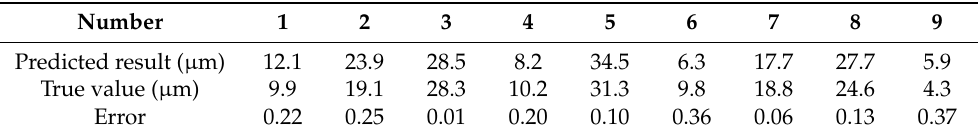
Table 5. Comparison of predicted result and true value.